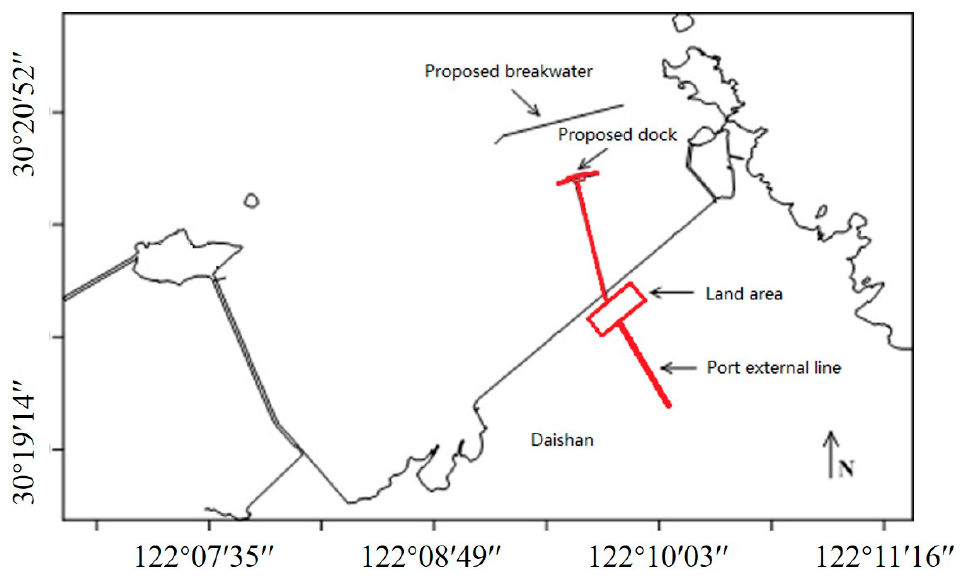
Figure 9. The layout of plan I.